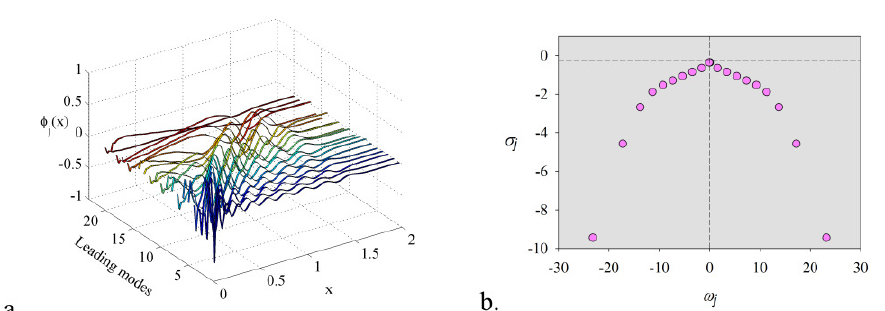
Figure 7. The case Re = 10 2 : ( a ) The DMD leading modes, ( b ) Growth rates and associated frequencies ( σ , ω ) of the eigenvectors of the Koopman matrix S .